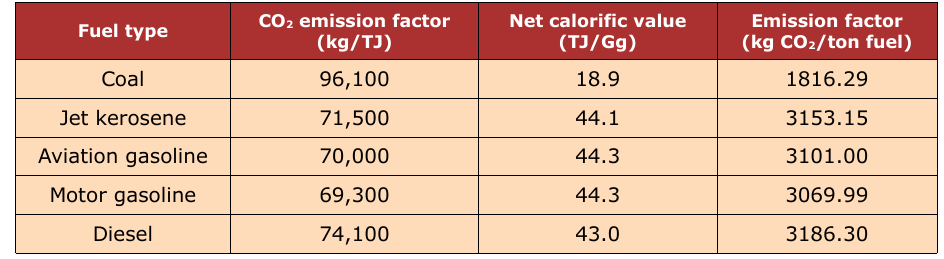
Table 2. CO 2 emission factor by type of transport